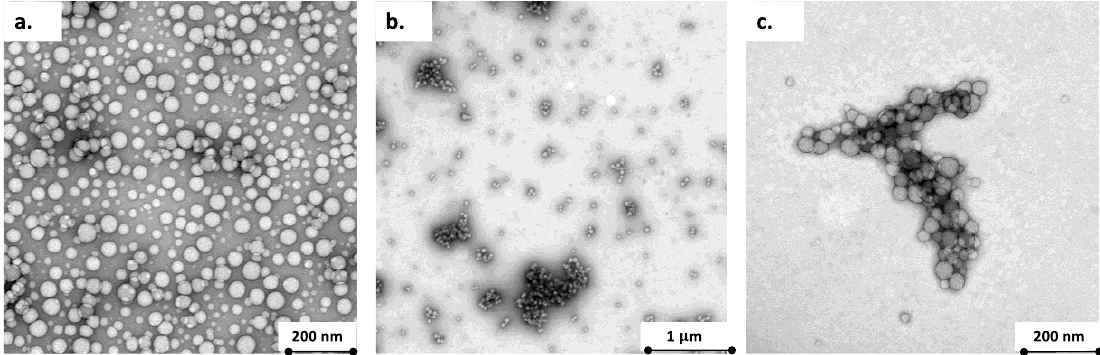
Figure 1. TEM observations of ( a ) PS50, and ( b , c ) PS50-HA (I = 700 mmol·L −1 ).